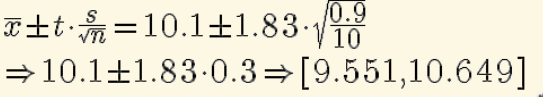
Fig. 5. Example of the solution to an online quiz